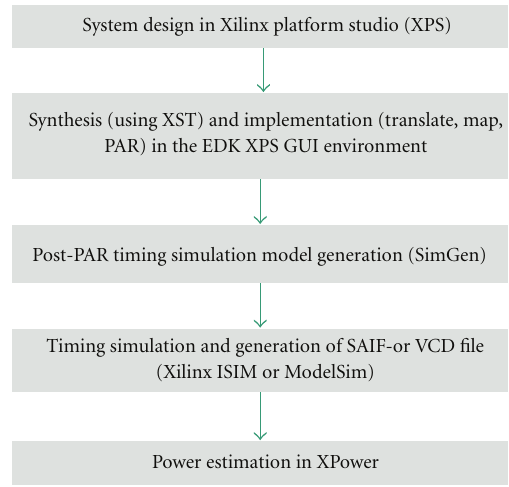
Figure 1: Diagram of the EDK XPower